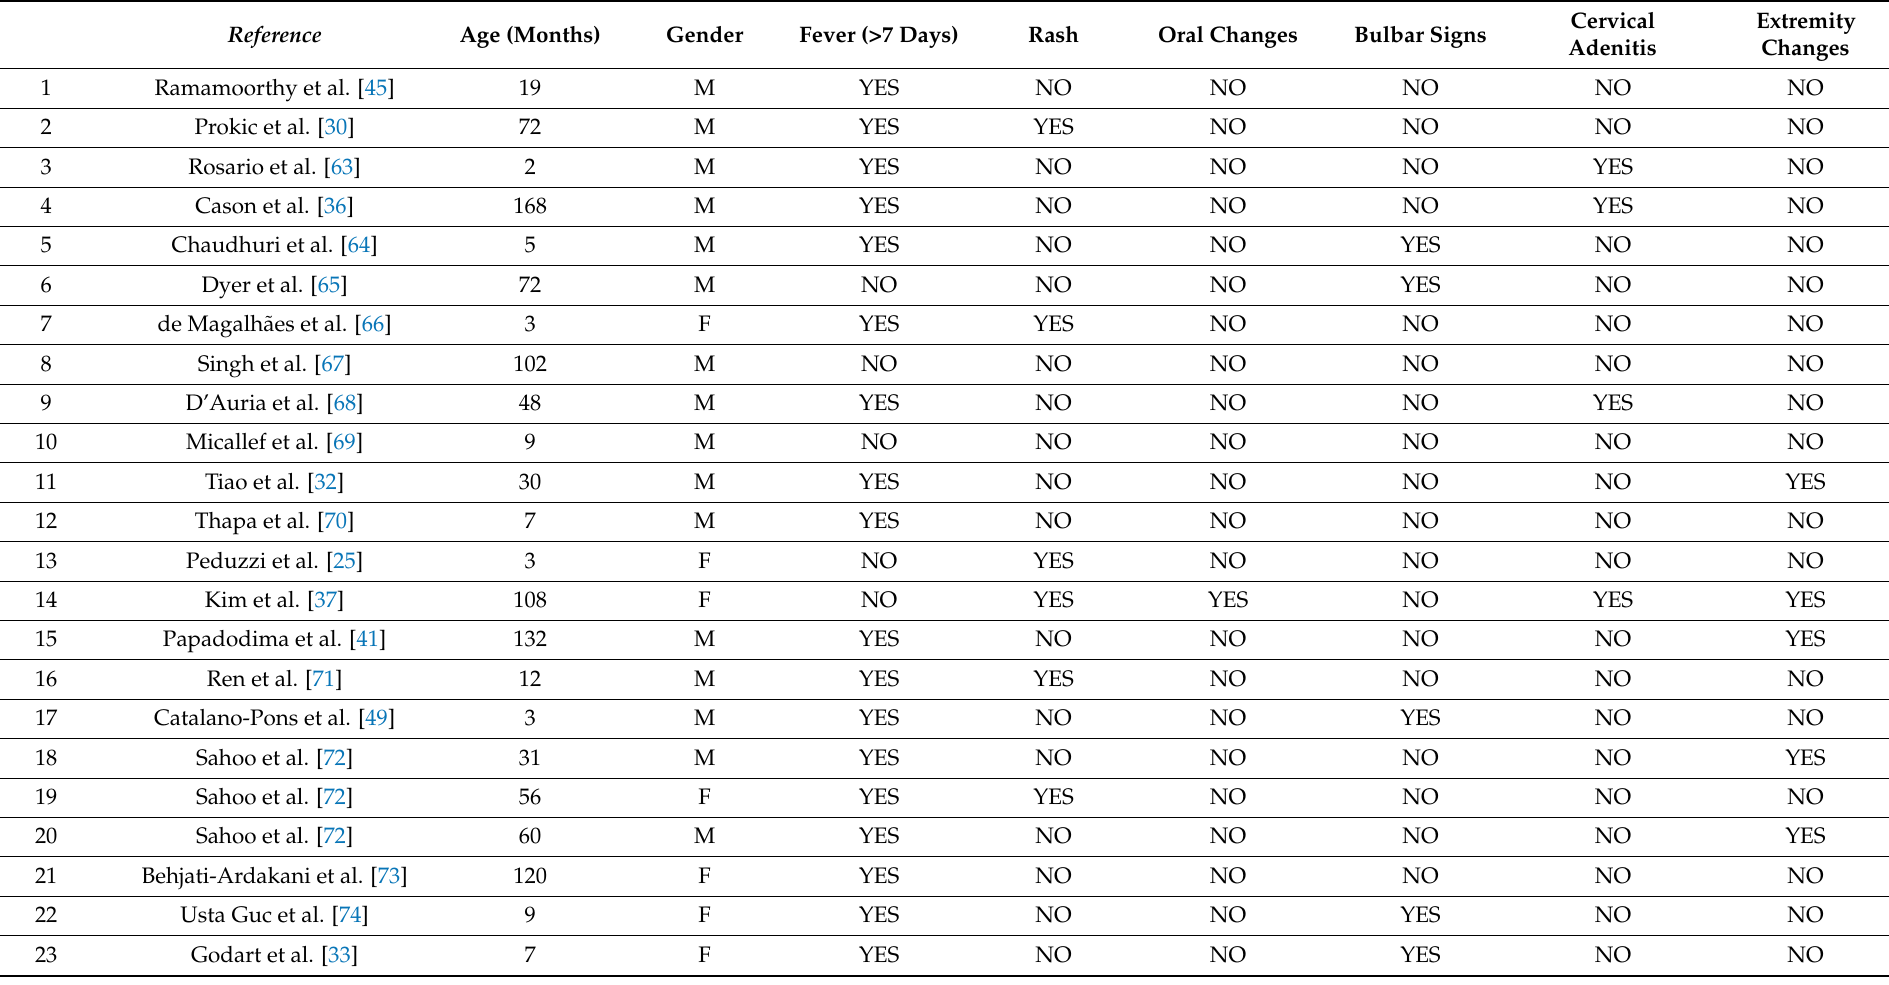
Table 1. List of the general features and classical manifestations (according to the American Heart Association criteria) in case reports presenting ‘atypical’ pictures of Kawasaki